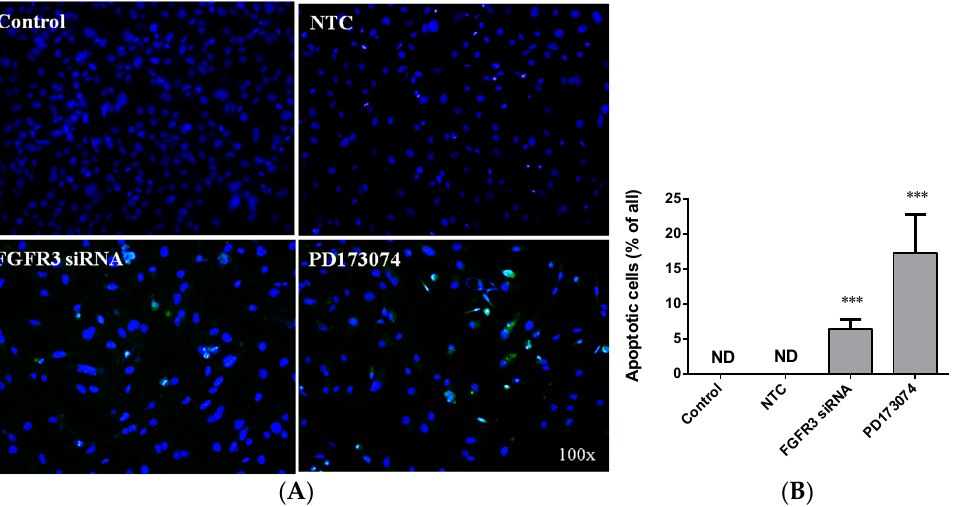
Figure 6. Effect of FGFR3 gene silencing on constitutive expression of RAS and phosphorylation of MAPK signaling mediators in cultured UTUC cells. ( A ) BFTC-909 cells were treated with FGFR3-targeted siRNA or scramble non-target control (NTC) for 48 h and subjected to Western blotting detection. GAPDH was used as loading internal control. ( B ) Densitometry analyses for protein expression levels of FGFR3 ( B ) and RAS ( C ) are shown as ratios to GAPDH, and phosphorylation levels of EKR1/2 ( D ) and JNK1/2 ( E ) are shown as ratios to respective total proteins. Density data are expressed as mean ± SEM ( n = 3). * indicates a p < 0.05 between the indicated groups.